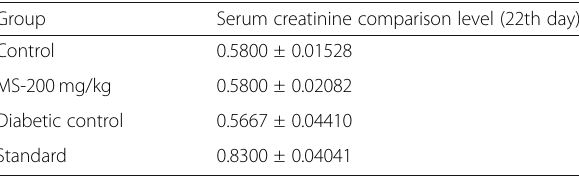
Table 3 Effect of EMSL on serum creatinine level on alloxan induced diabetic nephropathy